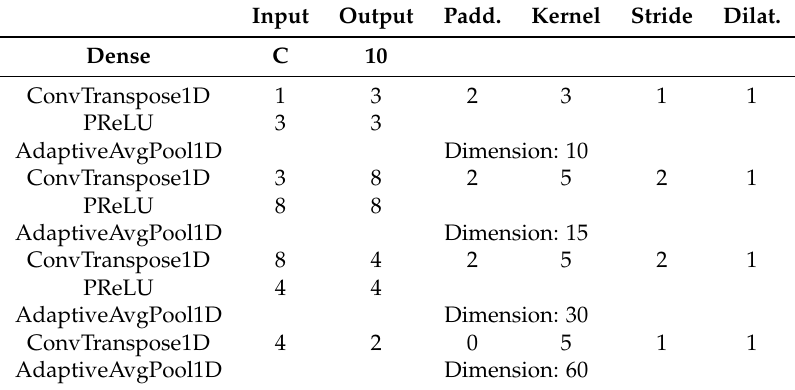
Table 2. The parameters of the